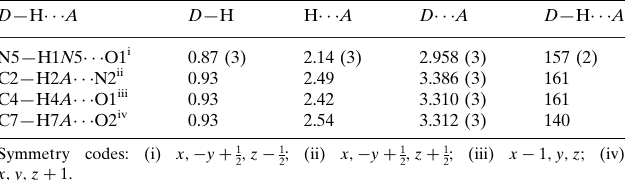
Hydrogen-bond geometry (A˚ , (cid:2)